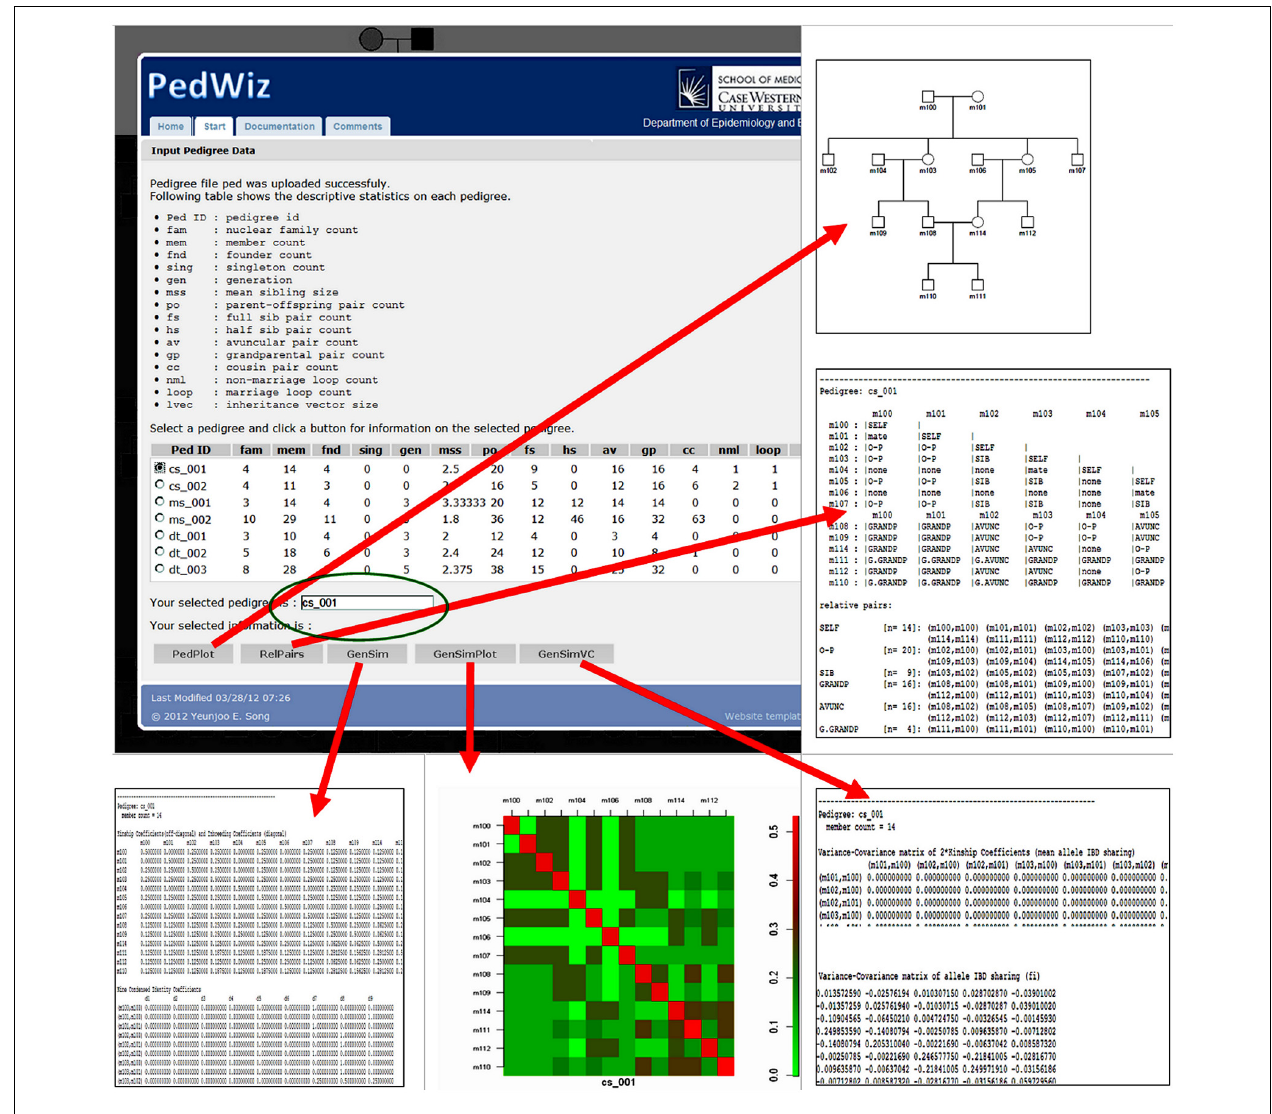
FIGURE 3 | Different types of outputs from PedWiz . All results are accessed through a set of buttons under the descriptive statistics table for each